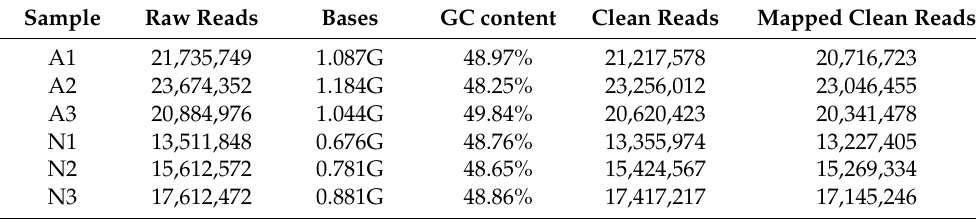
Table 1. Read statistics for six bovine testes miRNA-seq